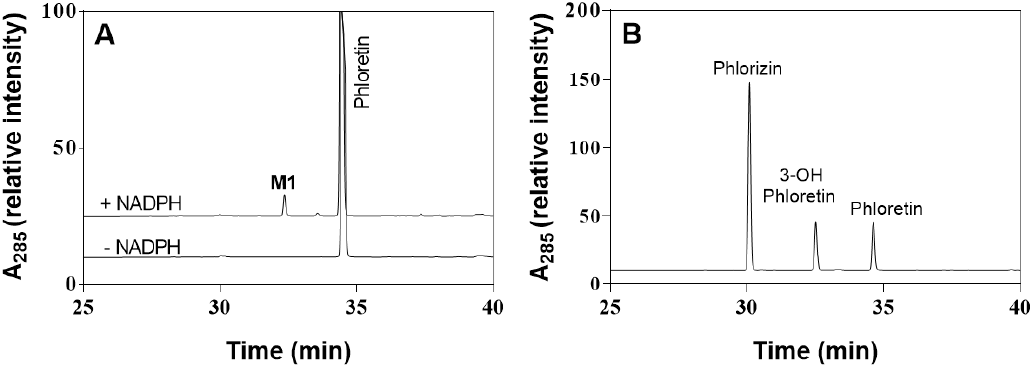
Figure 2. HPLC chromatograms of phloretin and its metabolites via human liver microsomes. ( A ) Peaks of the reaction mixtures were identified by comparing their retention times ( t R ) with those of standard compounds: ( B ) 3-OH phloretin ( t R = 32.4 min), phloretin ( t R = 34.6 min), and phlorizin ( t R = 30.1 min).